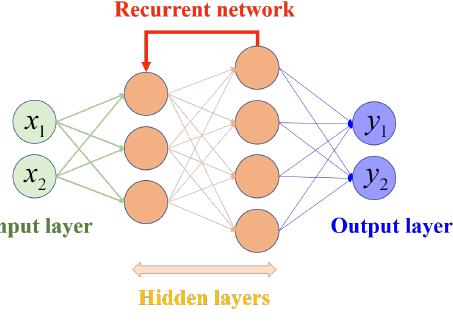
Figure 8. Example of RNN architecture.